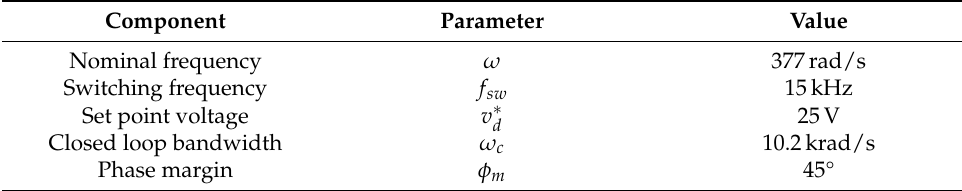
Table 2. Boost inverter operating conditions